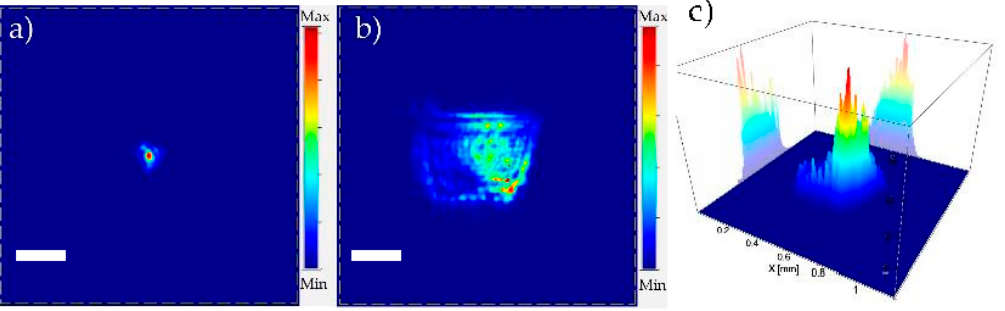
Figure 3. IR beam profile measured on the end facet of multimode fibre ( a ) and blunt-tip silicon shaft of a fully functional optrode chip ( b ). 3D view of the intensity of IR beam profile coupled out from the electrode’s shaft ( c ). The pixel intensity is in arbitrary units in all figures. Scale bar shows 300 µm on both of Figure 3a,b.